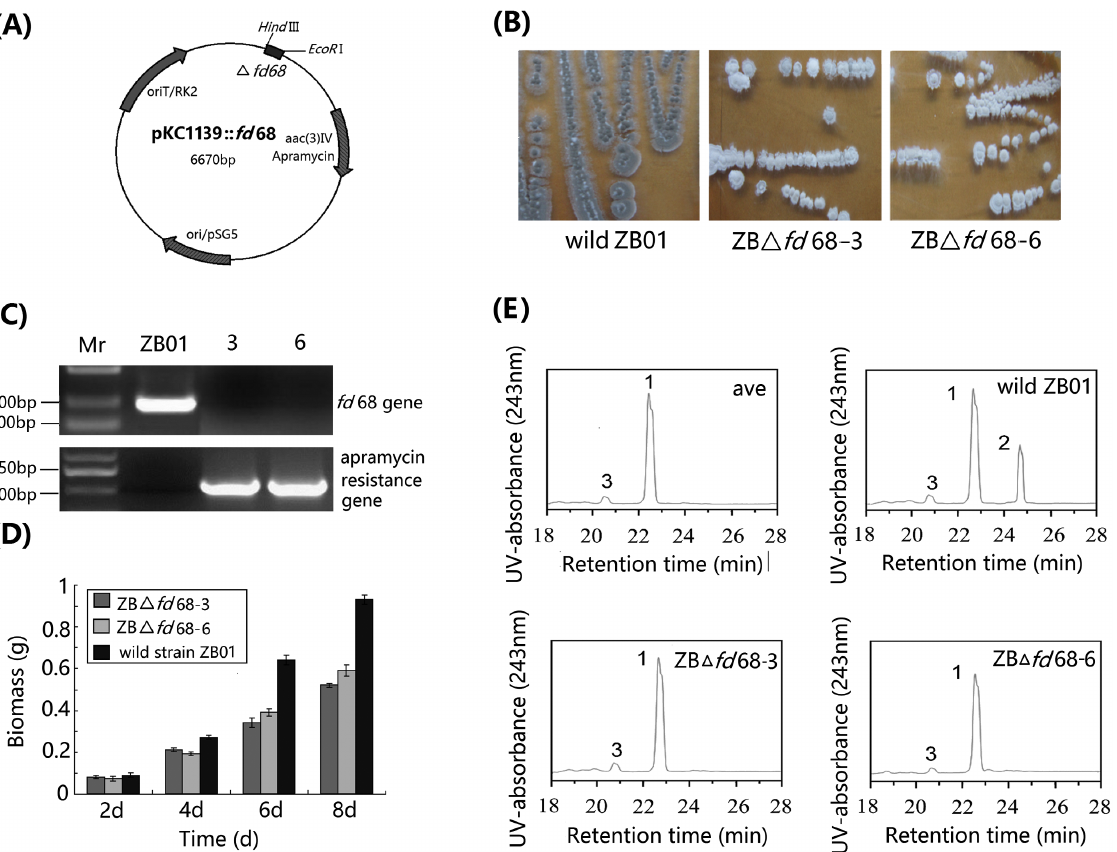
Figure 3. Characterization of fd 68 gene disruption mutants of S.ahygroscopicus ZB01. (A) Map of the fd68 knock-out plasmids pKC1139:: fd 68. The 172bp fd 68 fragment named D fd68 was subcloned into the EcoR I and Hind III sitesa of lacZ a MCS in plasmid pKC1139. (B) Phenotype of wild S. ahygroscopicus ZB01 and fd 68 disruption mutants ZB D fd 68-3 and ZB D fd 68-6 (7 d on YMS medium at 30 u C). Note the color changes of the colonies of the strains. (C) PCR analysis of apramycin resistance gene and fd 68 with primers AF1/AR1 for apramycin resistance gene and fF1/fR1 for fd 68; Mr, DNA Marker. The line above the lane numbers indicates DNA from wild-type strain S. ahygroscopicus ZB01, mutant ZB D fd 68-3 and ZB D fd 68- 6. (D) Mycelium dry weights of fd 68 disruption mutants ZB D fd 68-3, and ZB D fd 68-6 and wild-type S. ahygroscopicu ZB01 at different incubation times in YEME. 10 8 spores of strains were inoculated in 250 ml flasks with 80 ml liquid YEME medium and cultured for 8 d, the mycelium were collected and dried at 70 u C for 1 d. Error bars represent the standard deviation of three replicas in three independent experiments. (E) HPLC analysis of the products of avermectin catalyzed by avermectin standard, wild S. ahygroscopicus ZB01, ZB g fd 68-3 and ZB g fd 68-6. The peaks of avermectin B1a and metabolites are indicated. The 1 represents the peak of avermectin B1a, 2 represents the peak of 4 0 -oxo-avermectin, and 3 represents the peak of avermectin B1b. The retention times for avermectin B1a is 22.5 min, for 4 0 -oxo-avermectin B1a is 24.7 min, and for avermectin B1b is 20.7 min.